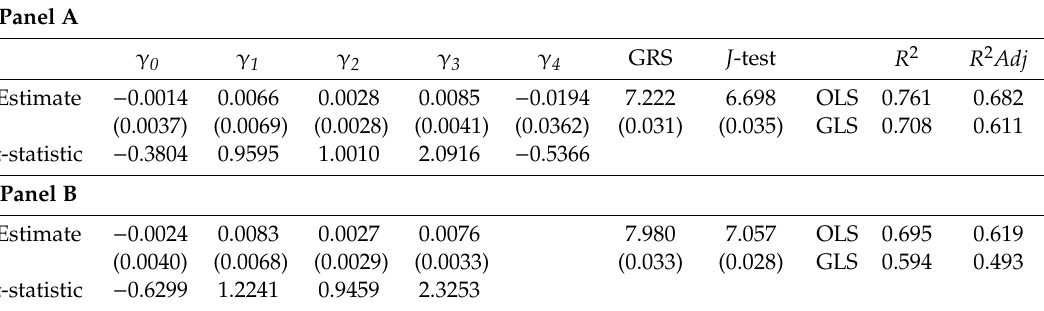
Table 6. Cross-section regression results 1